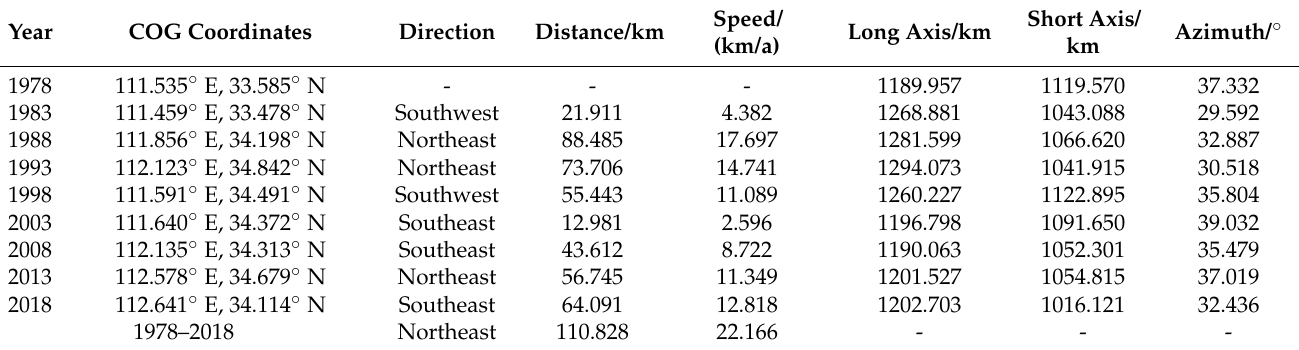
Table 2. Parameter changes of the COG and SDE of APE in China since 1978.